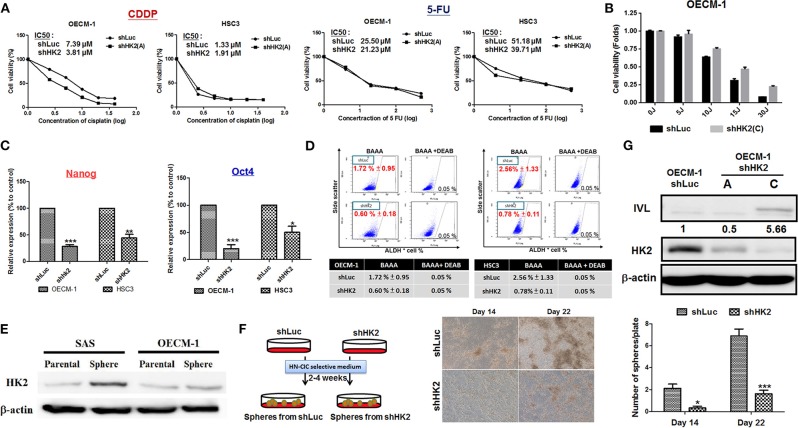
HK2 loss modulated therapeutic sensitivity in HNSCC Cells. (A) Decreased IC50 for clinical chemotherapeutic agent CDDP and 5-FU, whereas (B) greater resistance in response to photodynamic therapy was detected in HK2-deficient HNSCC cells. This effect is probably regulated via decreased (C) Nanog/Oct4 mRNA expression and/or (D) ALDH activity. While (E) HK2 is highly expressed in SAS and OECM-1 derived sphere cells compared with parental cells, (F) HK2 loss resulted in decease of sphere formation. (G) Upregulation for cellular differentiation marker involucrin (IVL) protein was detected by Western blot analysis in HK2-silencing HNSCC cells. Data are presented as mean ± SEM (N ≥ 3). ***p < 0.001, **p < 0.01, and *p < 0.05.